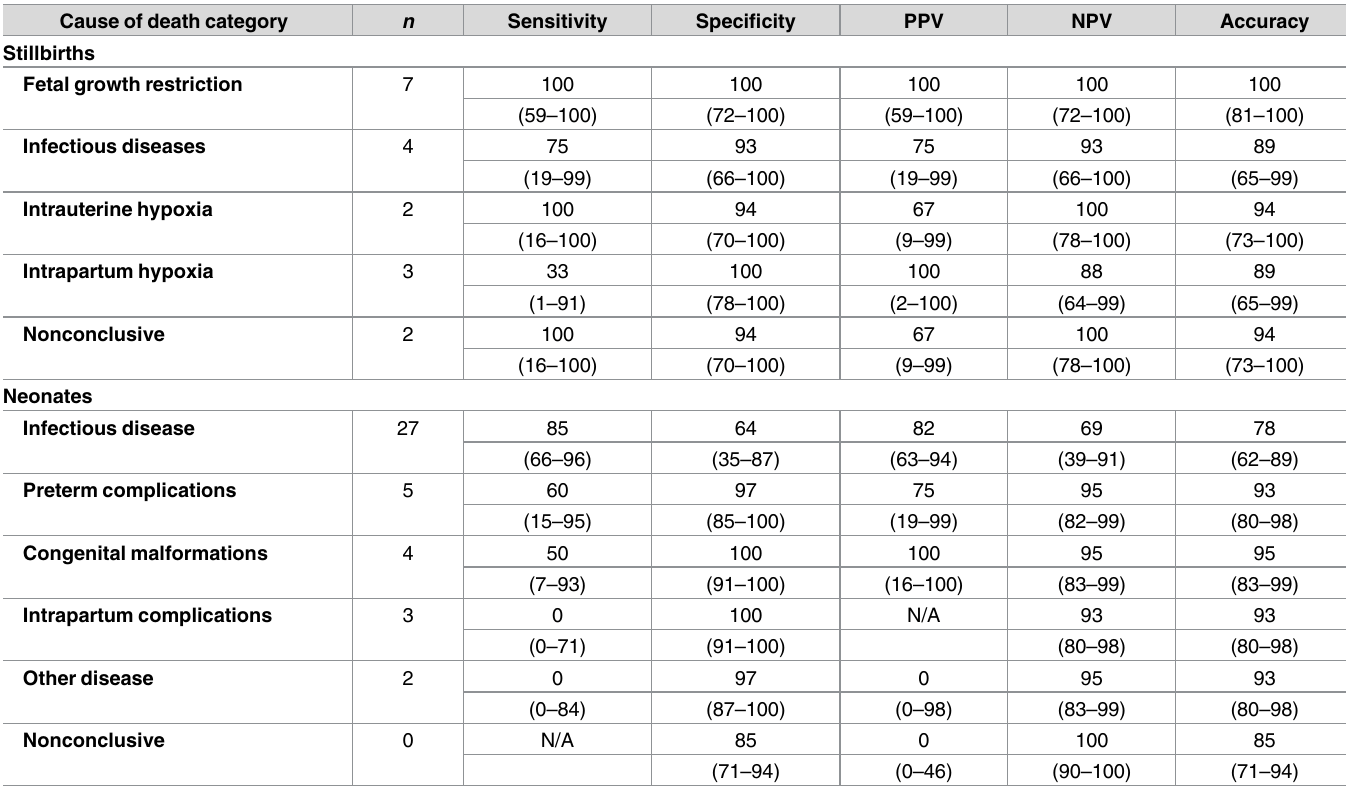
Table 5. Sensitivity, specificity, positive and negative predictive value (PPV and NPV), and accuracyof the minimally invasive autopsy (MIA) for the different diagnostic categories in stillbirths and neonates. Figures are percentages and 95%